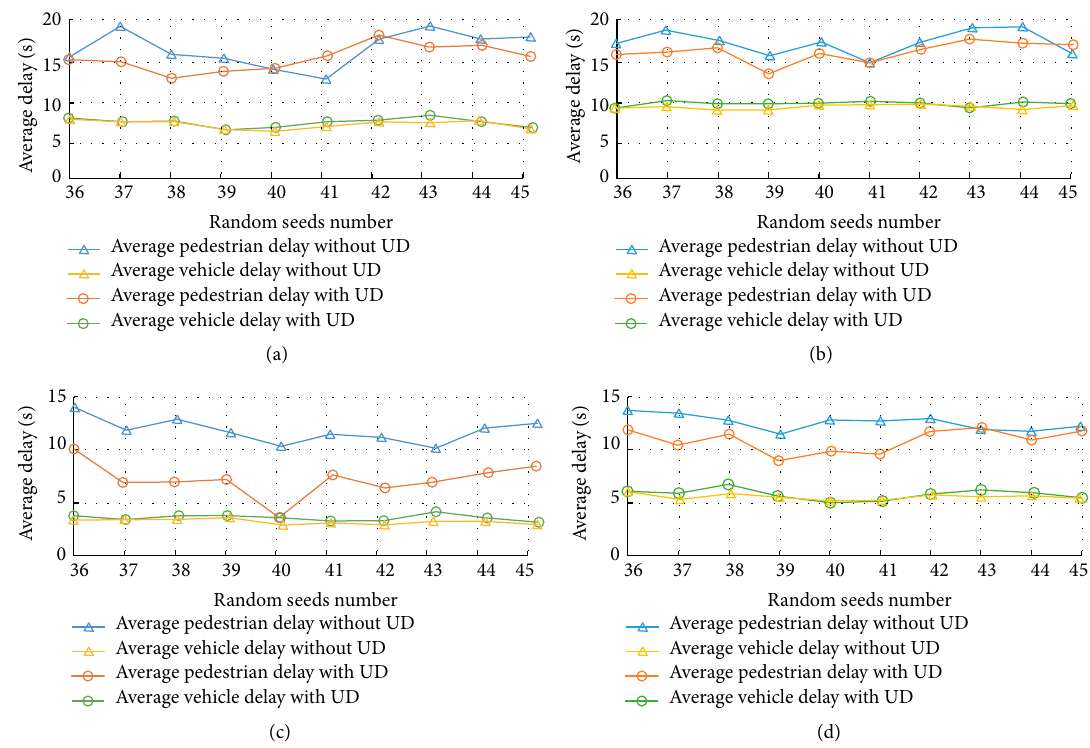
Figure 7: Simulation results of PHB models with and without UD strategy: (a) Longpan road crosswalk in off-peak hour; (b) Longpan road crosswalk in peak hour; (c) Huayuan road crosswalk in off-peak hour; (d) Huayuan road crosswalk in peak